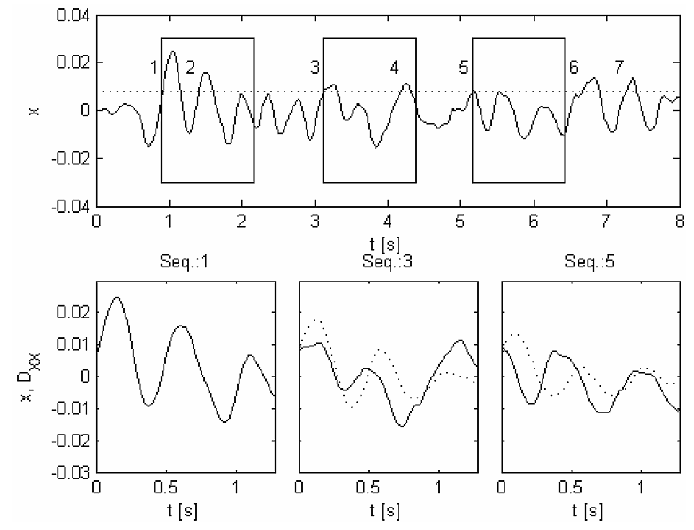
Fig. 2. Example for the calculation of a RD signature with a simple level crossing trigger condition. Upper part: time history, lower part: Time sequences (solid) and averaged RD signature (dashed).